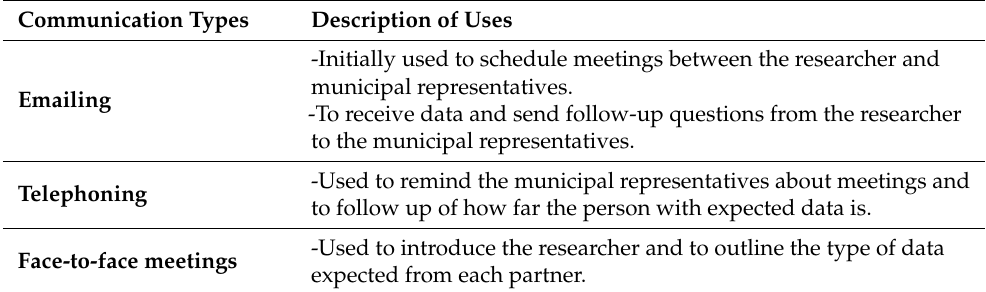
Table 1. Detailed gathering communication methods